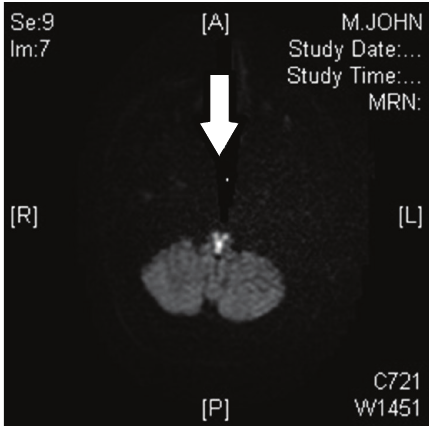
Figure 4: Second brain MRI, DWI shows characteristic “heart appearance” sign suggestive of bilateral medial medullary